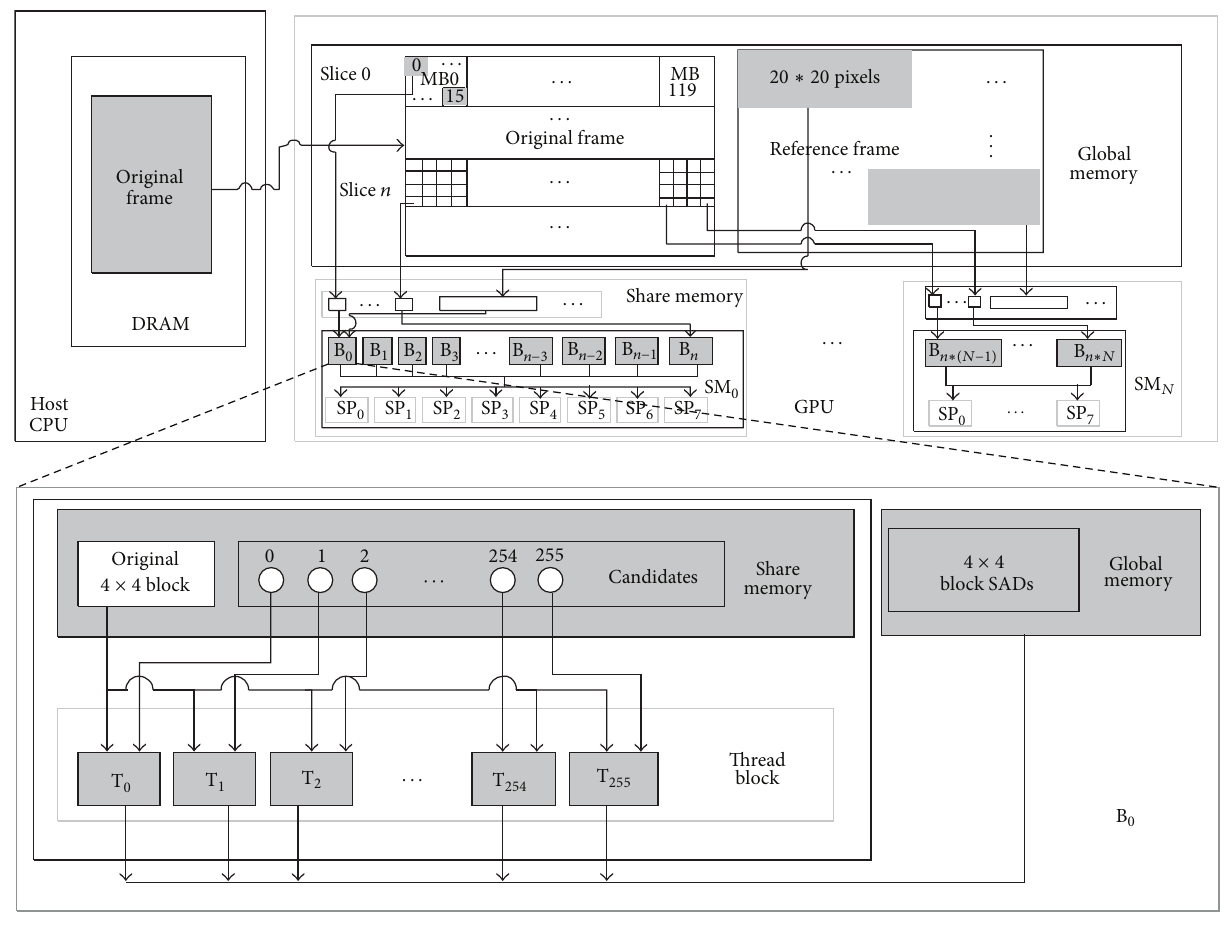
Figure 5: The parallel model for SAD computing of 4 × 4 subblocks.